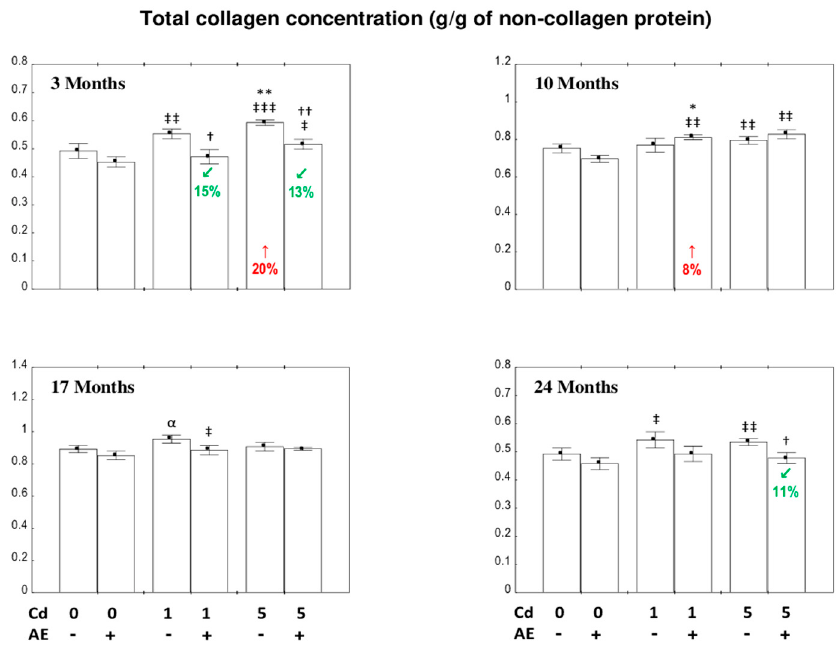
Figure 1. The impact of extract from Aronia melanocarpa L. berries (AE) on the concentration of total collagen in the livers of rats exposed to cadmium (Cd). The animals were treated with Cd at the concentrations of 0, 1, and 5 mg Cd/kg in their diets and/or 0.1% aqueous AE (+) or not ( − ). Data are shown as mean ± standard error (SE) for eight rats, except for seven animals in the AE, Cd 1 , and Cd 5 groups after 24 months. Statistically significant differences (Kruskal–Wallis post hoc test): * p < 0.05, ** p < 0.01, and α p < 0.06 vs. control group; † p < 0.05 and †† p < 0.01 vs. appropriate Cd group; ‡ p < 0.05, ‡‡ p < 0.01, and ‡‡‡ p < 0.001 vs. AE group. Numerical values in bars express the percentage changes in comparison to the control group ( ↑ , increase) or the appropriate group exposed to Cd alone ( ↙ , decrease).